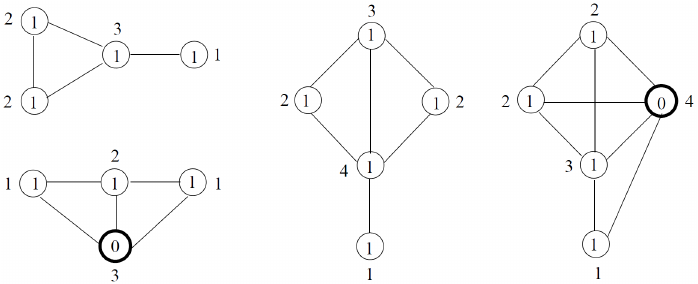
Figure 3: The four graphs of order 4 or 5 having an antiregular total dominating function.